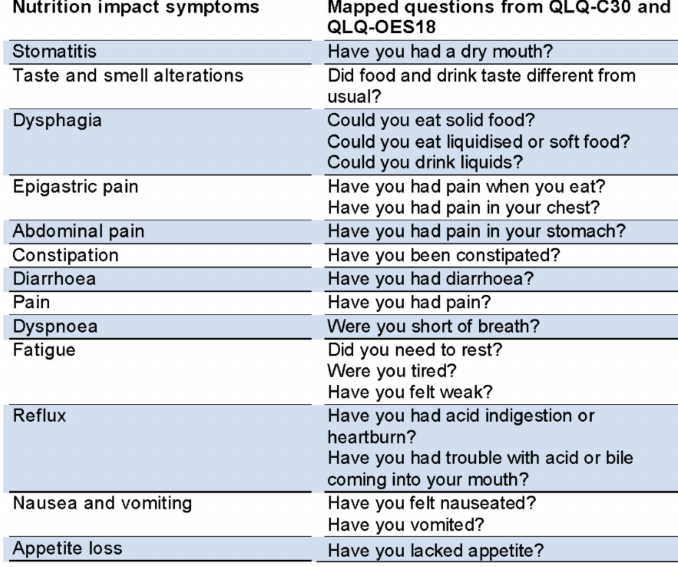
Figure 1. Nutrition impact symptoms mapped to EORTC questionnaires QLQ-C30 and QLQ-OES18. QLQ—Quality of life questionnaire; EORTC—European Organisation for Research and Treatment of